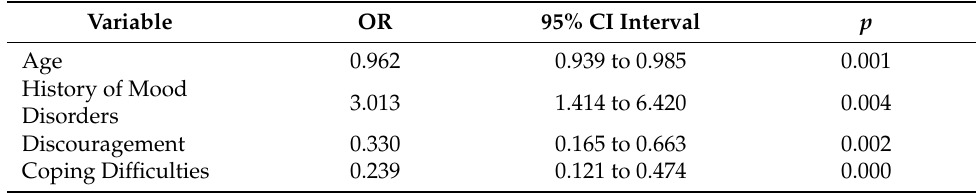
Table 3. Characteristics of patients associated with a desire for psychological help: logistic regression model (n = 229). “Discouragement” and “Coping Difficulties” were codified as “high” if patients stated “much” or “very much,” and as “low” if patients stated “not at all” or “not too much.” Variable